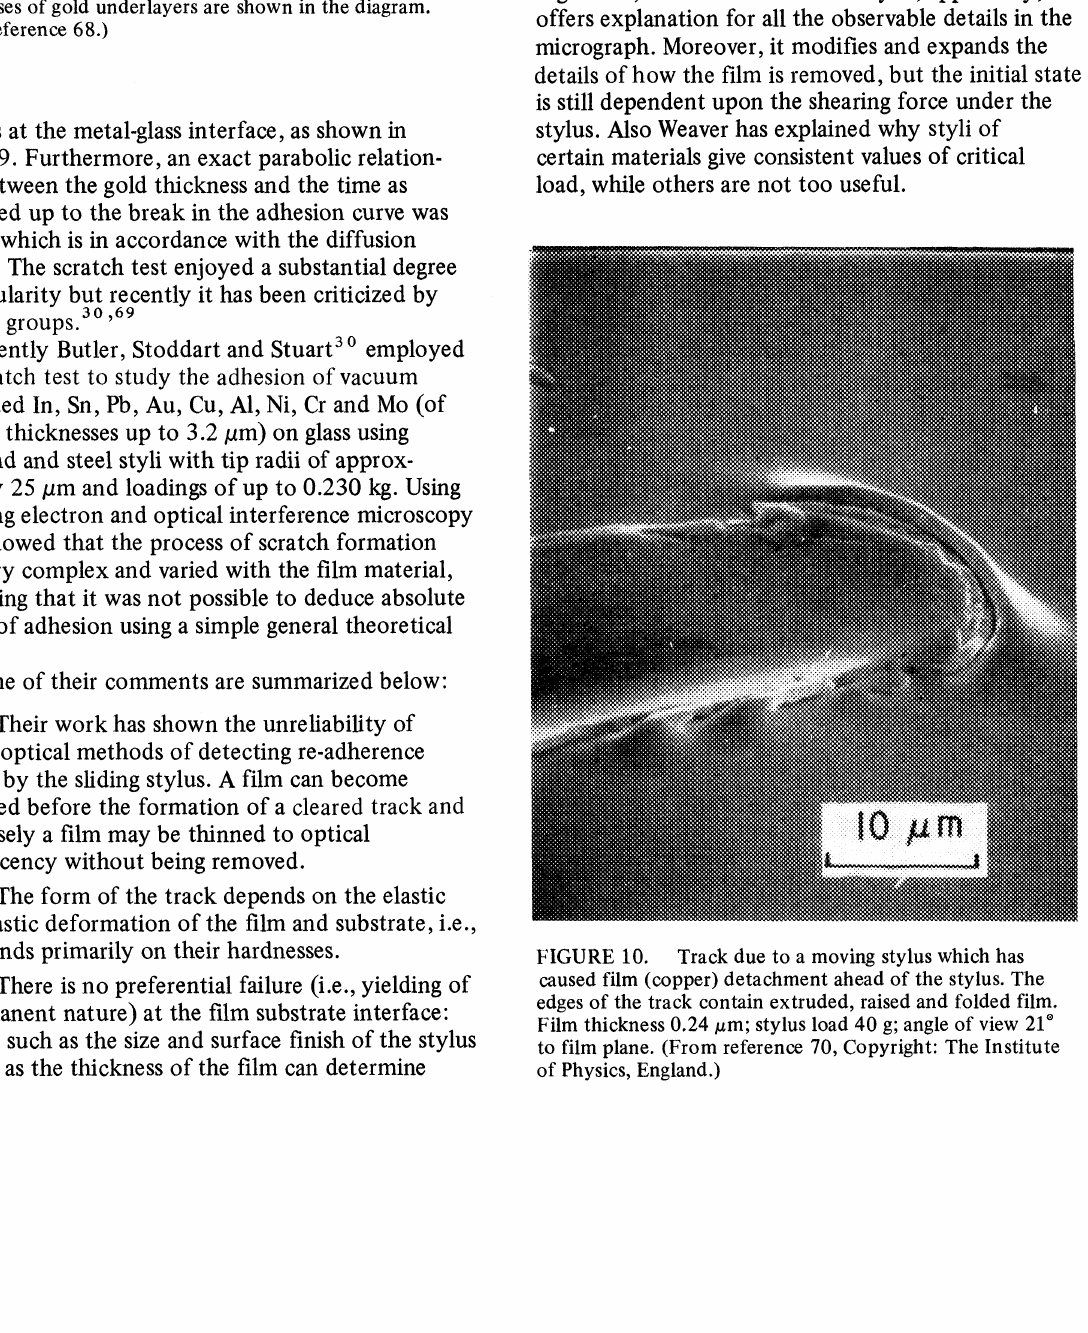
Adhesion changes during annealing of Au-A1 thin-film diffusion couples with gold underlayers. Different thicknesses of gold underlayers are shown in the diagram. (From reference 68.)